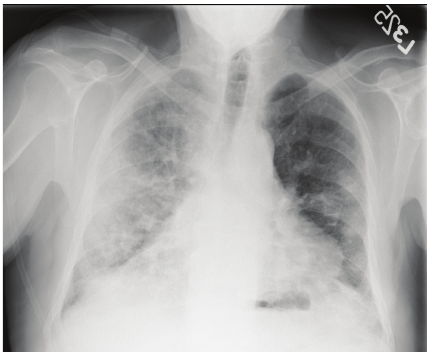
Figure 2: Chest X-ray on admission showing worsening bilateral lung opacities.